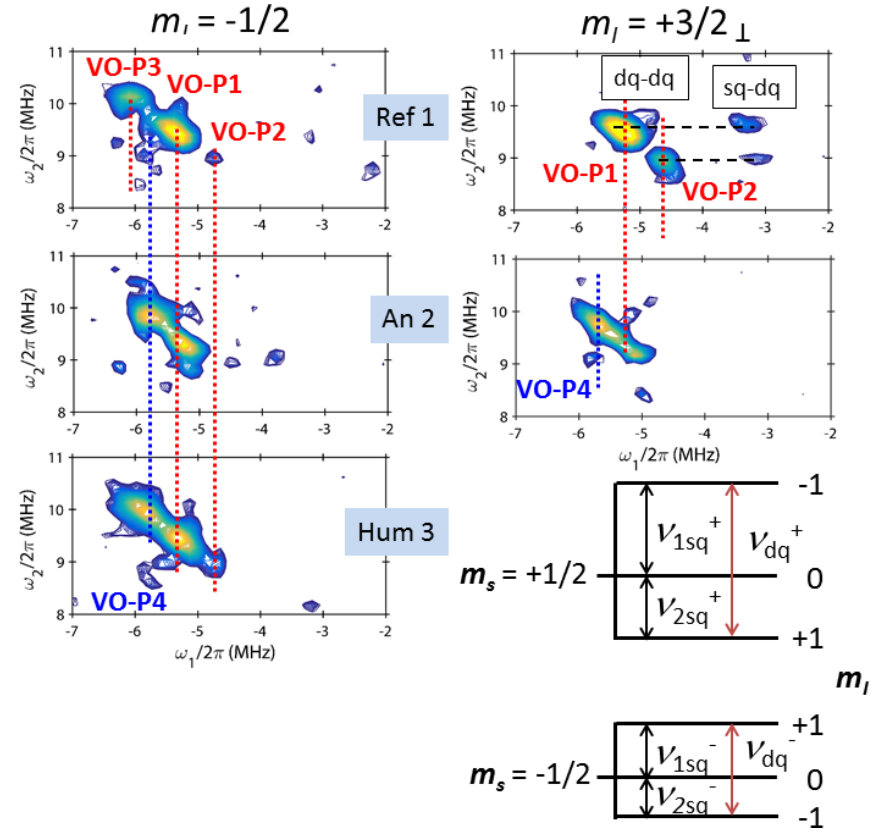
Figure 6. Portions of the HYSCORE spectra of Ref 1, An 2 and Hum 3 corresponding to dq–dq and dq–sq correlation peaks, where dq and sq represent double-quantum and single-quantum transitions, respectively. The diagram represents the spin states and the different nuclear transitions for a S = 1 / 2, I = 1 spin